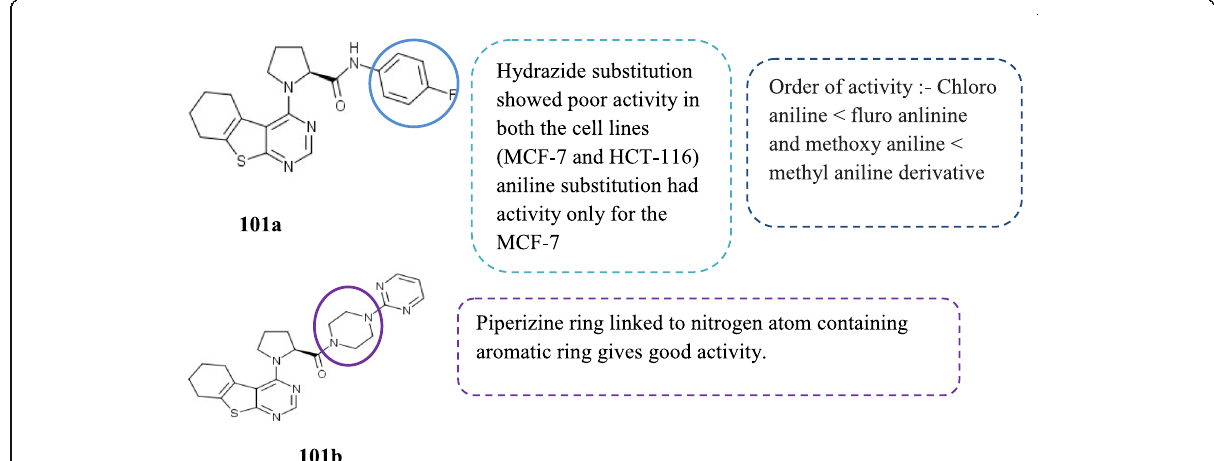
Fig. 34 SAR studies and chemical structures of new tetrahydrobenzo [4,5]thieno [2, 3-d] pyrimidine-4-yl)-pyrolidine-2-carboxylic acid derivatives